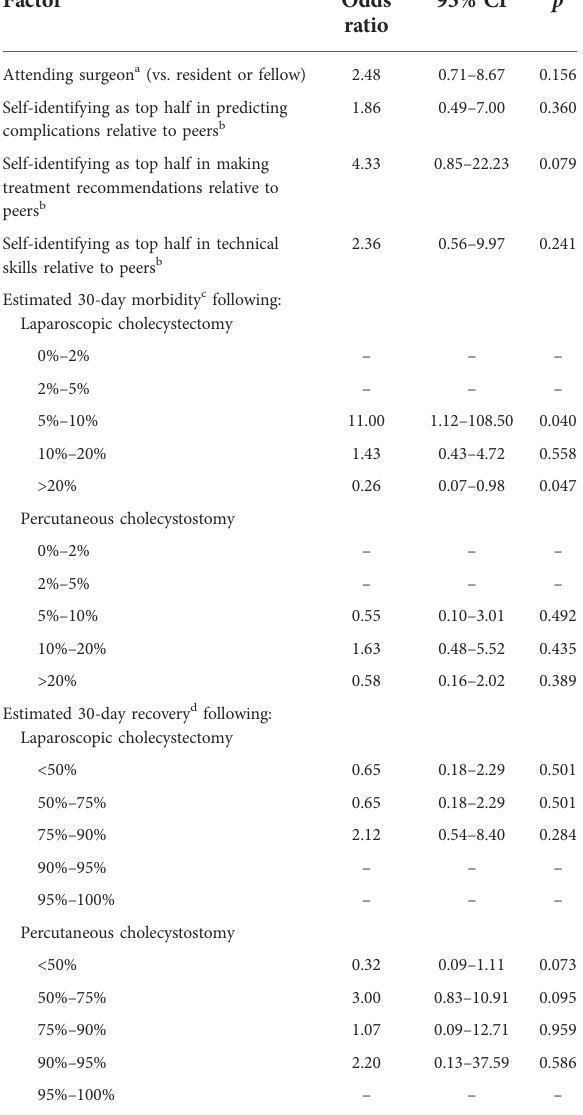
TABLE 2 Univariable predictors recommending laparoscopic cholecystectomy for severe acute cholecystitis. Factor Odds